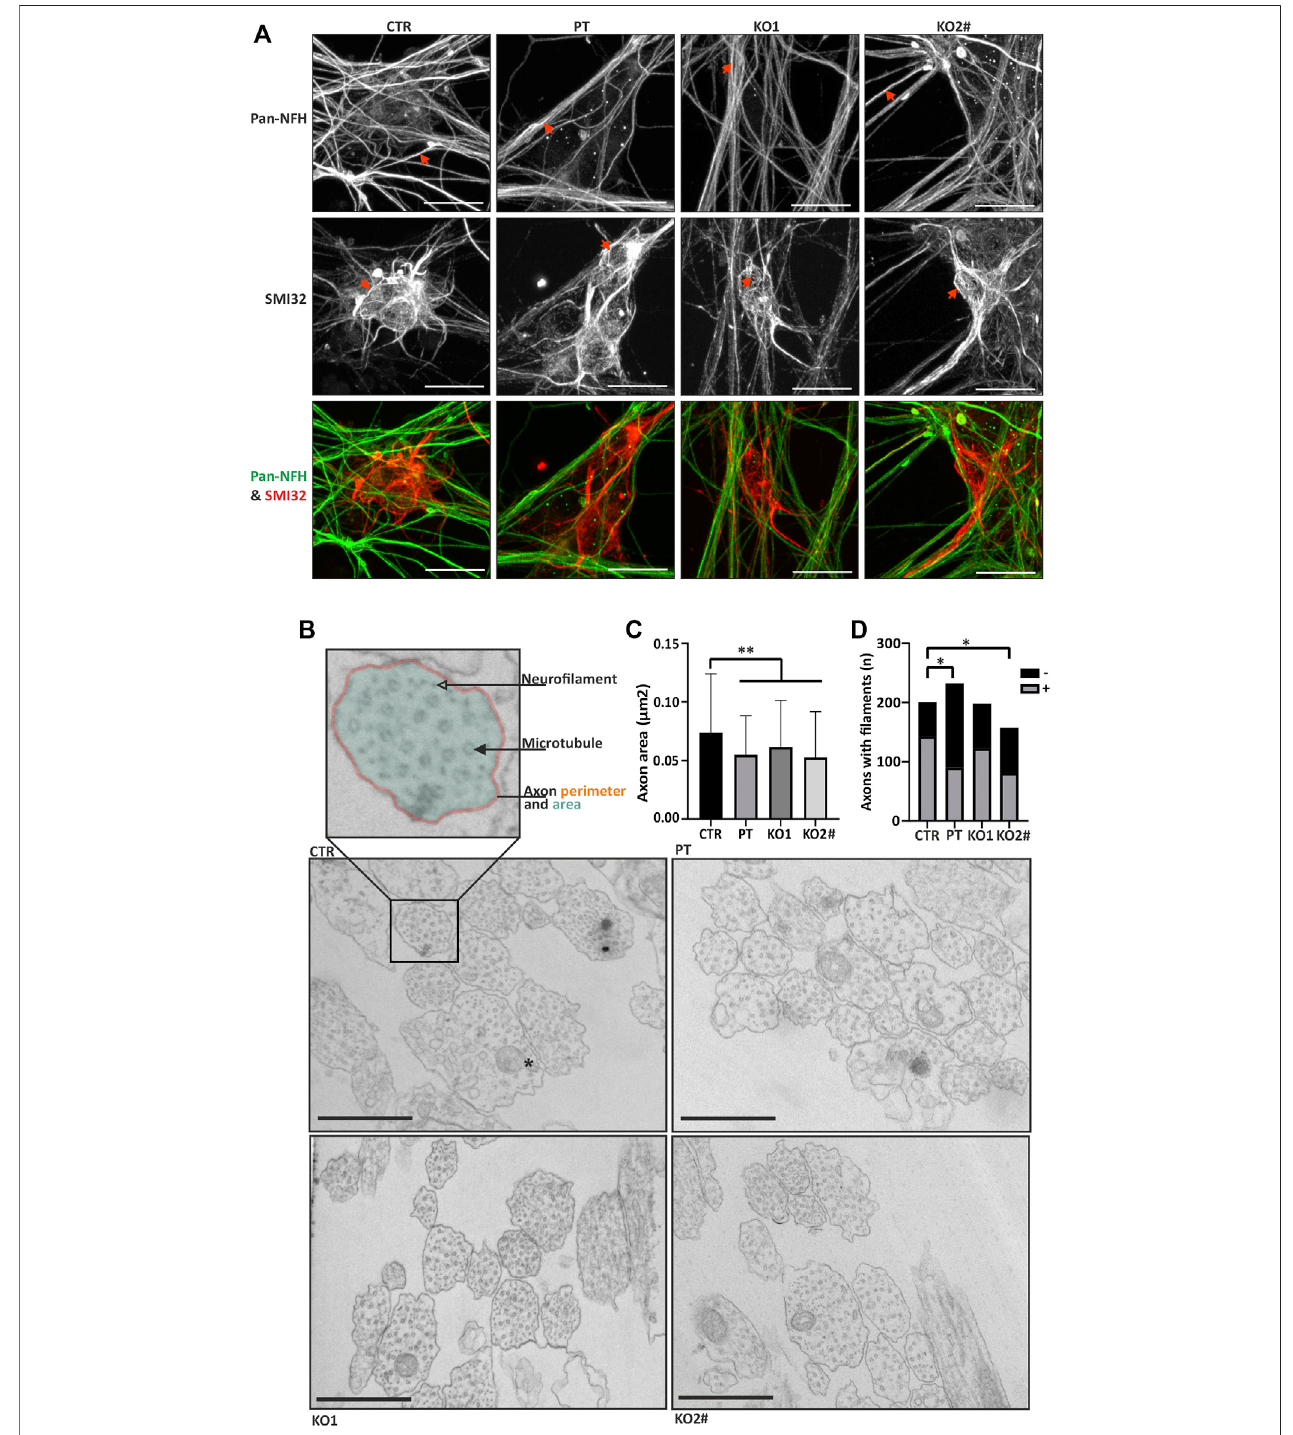
FIGURE 3 | iPSC-MN lacking NFL form fi lamentous structures and have a reduced axonal caliber. (A) Motor neurons (day 35) in all cell lines have fi lamentous structures in the neurites and soma. Spinning disc confocal z-stack imaging with maximum intensity projections reveals neuro fi lament-like structure in motor neurons. SMI32 red and pan-NFH (green). Scale bar 20 µm. Arrows indicate fi lamentous structures in iPSC-MNs. (B) Transmission electron microscopy reveals differences in axonal structure. Axon perimeter (orange outline), area (transparent teal fi ll) and presence of microtubules ( fi lled arrowhead), fi laments (transparent arrowhead) and mitochondria (asterisk in CTR panel) were assayed. Scale bar 500 nm. (C) Quanti fi cation of electron micrographs in B. con fi rms decreased axon area (PT/KO1/KO2 vs. CTR p < .0004)inpatient andknockoutiPSC-MNs. n =157 – 232axonsper cellline.Datashown asmeanwithSD.** p < .001.One-wayANOVAfollowedwithDunnett ’ s multiple comparison post-hoc test vs. CTR. (D) Proportion of neuro fi lament positive axons is reduced in PT (* p < .05, Fishers exact) and KO2 (* p < .05, Fishers exact). # indicates abnormal karyotype.